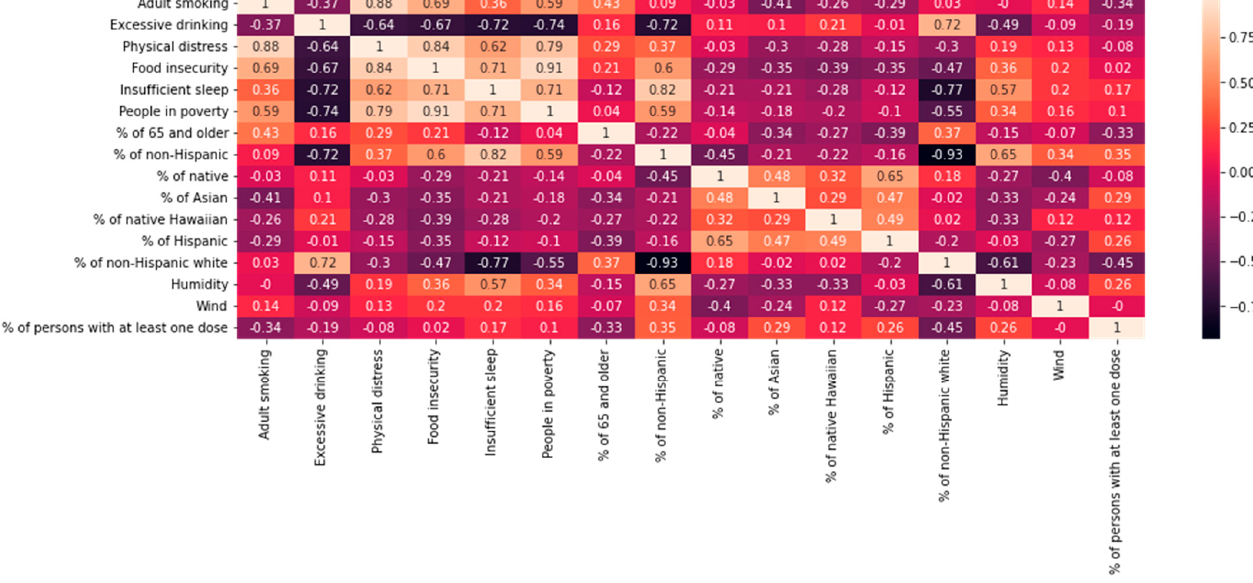
Figure A3. Population in 2020 in Arkansas. References 1.